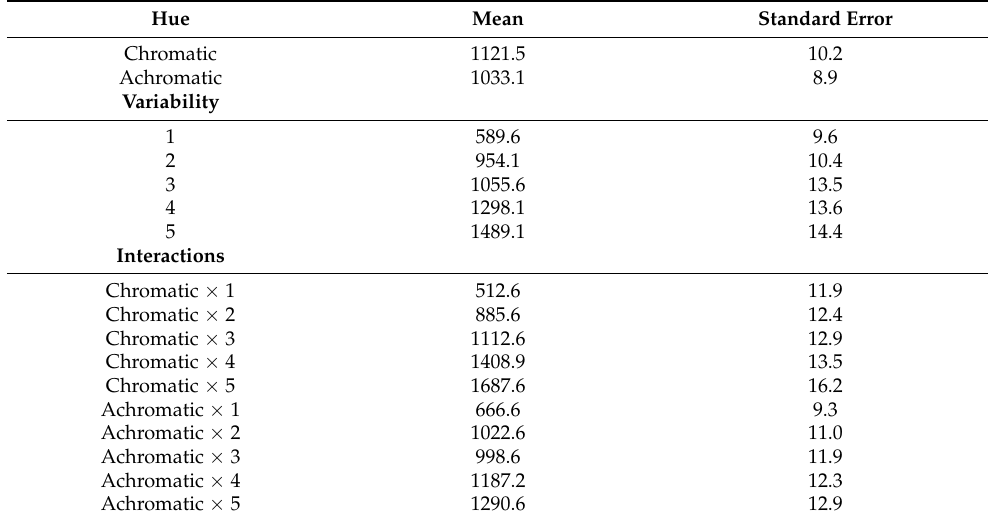
Table 3. Means and Standard Errors for the different Factor Levels and their Interactions.